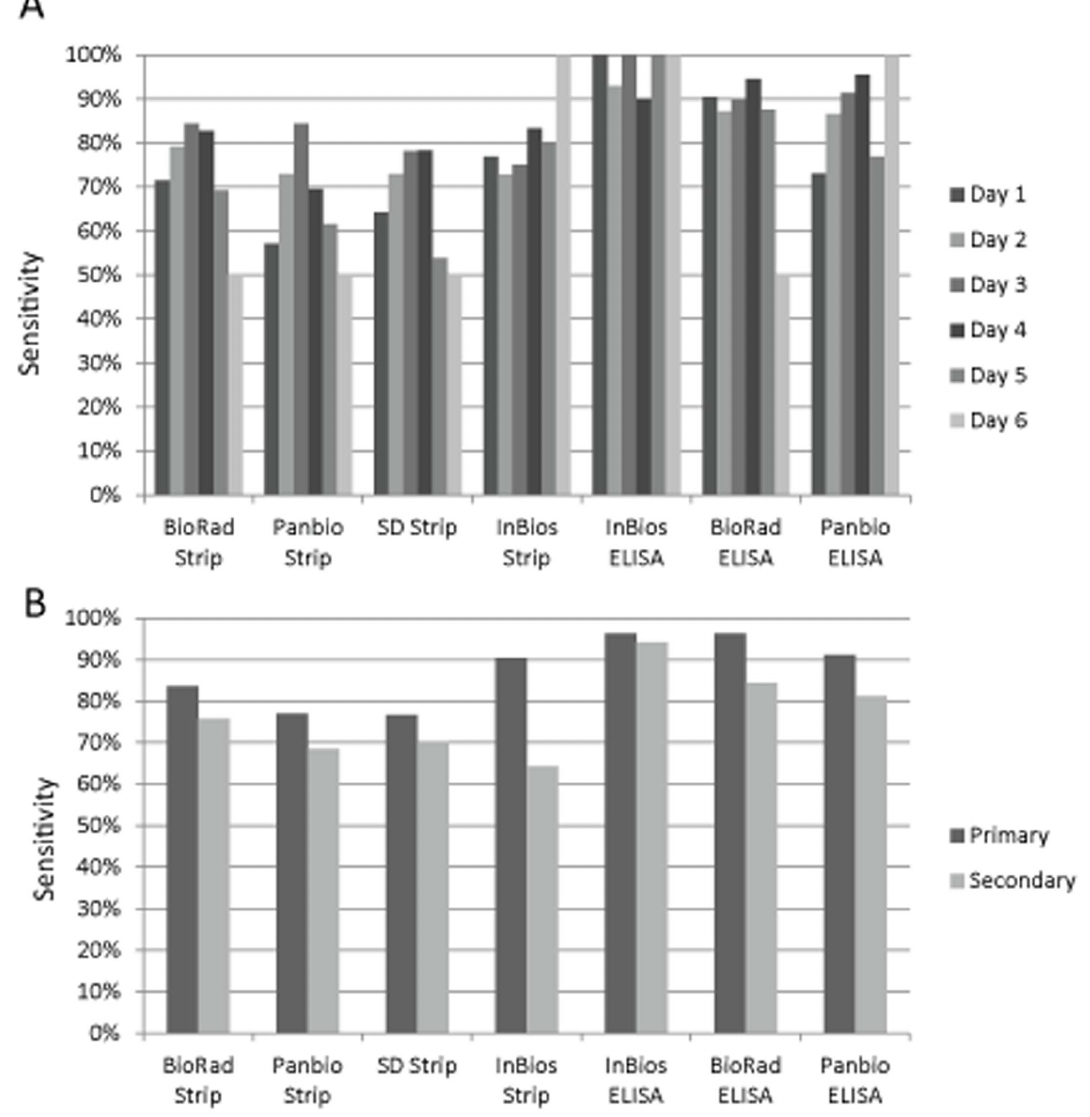
Figure 2. Device performance stratified by day post symptom onset and infection status. The diagnostic tests are shown on the X-axis, while the sensitivity of the device is shown in the Y-axis. Color of the bar denotes day PSO (A) or primary/secondary infection status